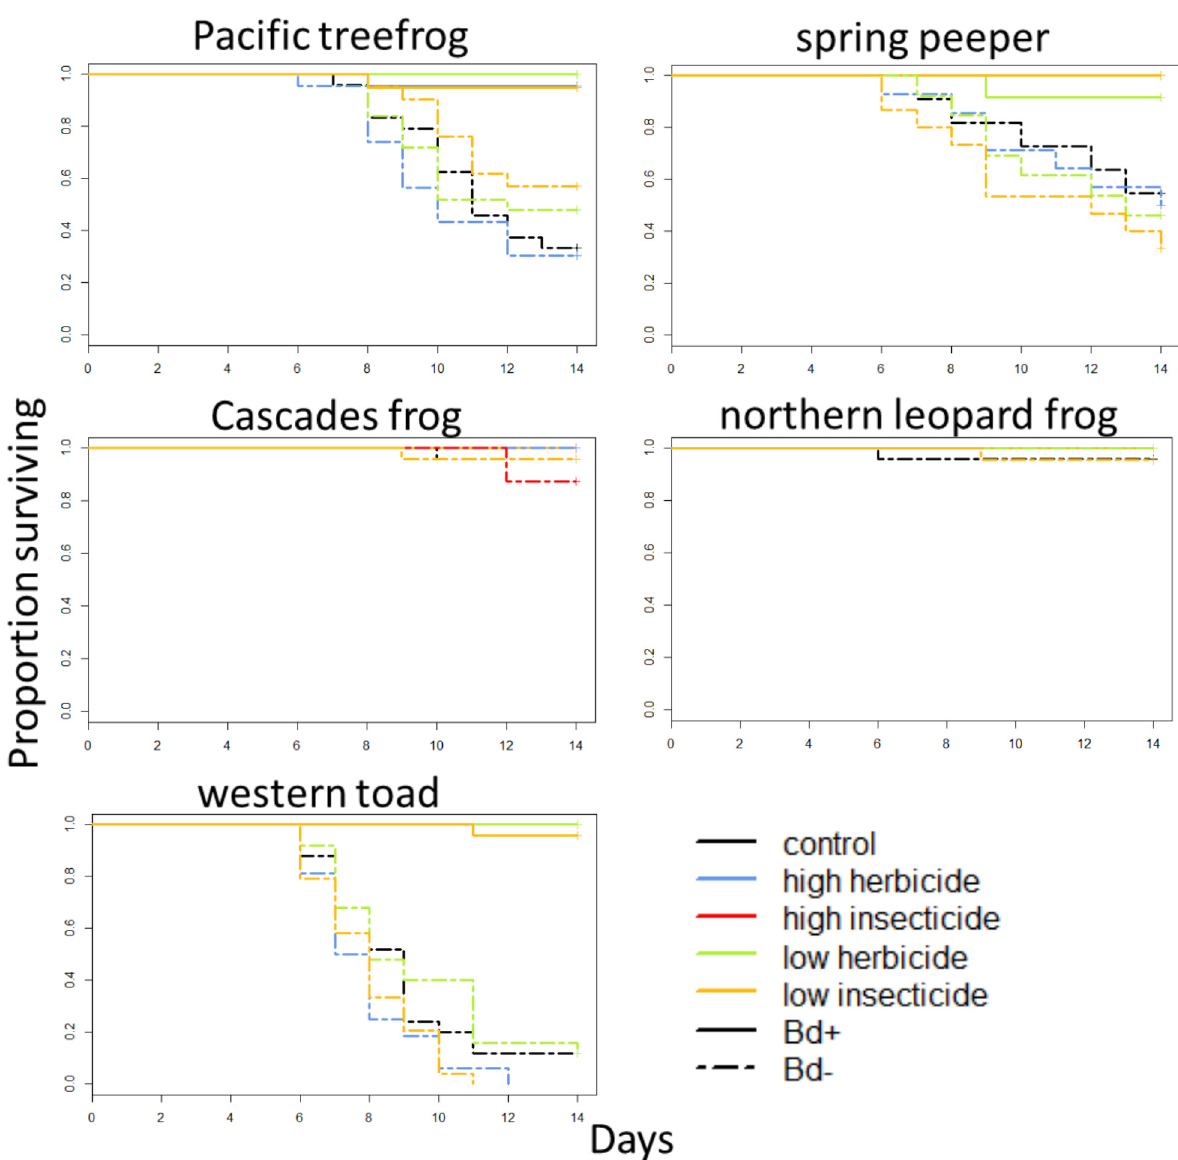
Fig 1. Survival of amphibians exposed to pesticides as tadpoles. Species are arranged phylogenetically (rows) and by geographic origin (columns). Dashed lines indicate Bd-exposed individuals, and solid lines indicate Bd-unexposed individuals.